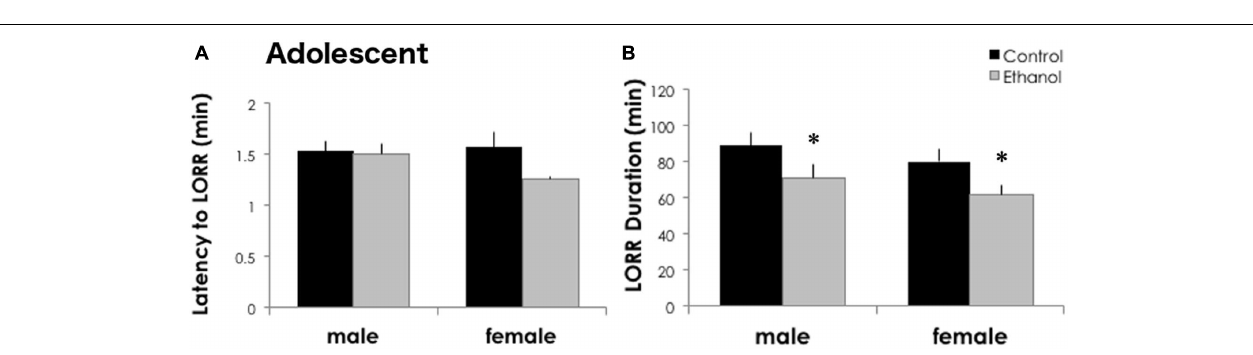
FIGURE 1 | Binge ethanol in adolescence increases locomotor activity in adolescence. Ethanol treatment did not alter the percent time in the light (A) or the percent distance traveled in the light (B) in the light–dark box 24 h after the last ethanol dose at PND 43 ( n = 7–10/group). Time spent ambulatory (C) and total locomotor distance traveled (D) in the 5-min test were significantly increased in ethanol exposed males and females. Data is presented as mean +/– SEM. ∗ p < 0.05, main effect of treatment by Two-Way ANOVA.